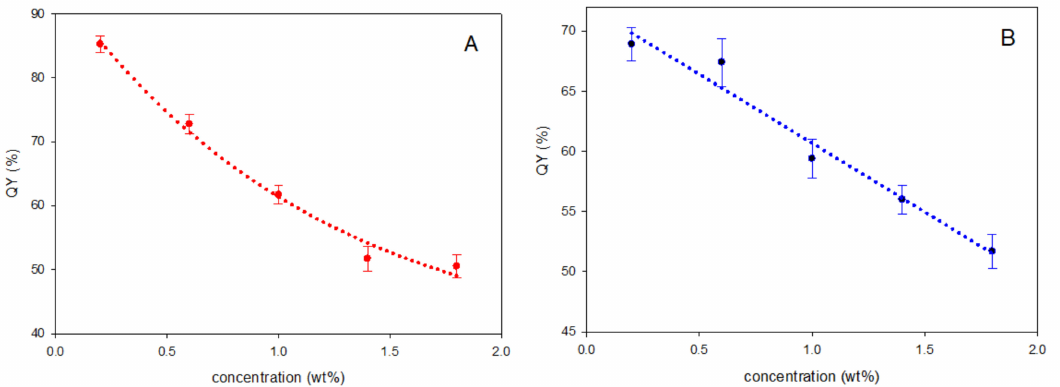
Figure 7. Quantum yields (QY) (%) of LR in ( A ) PCHMA and ( B ) PMMA films versus fluorophore concentration (wt%) with a thickness of 23 ± 6 µ m. Error bars represent standard deviation in each QY value ( n =